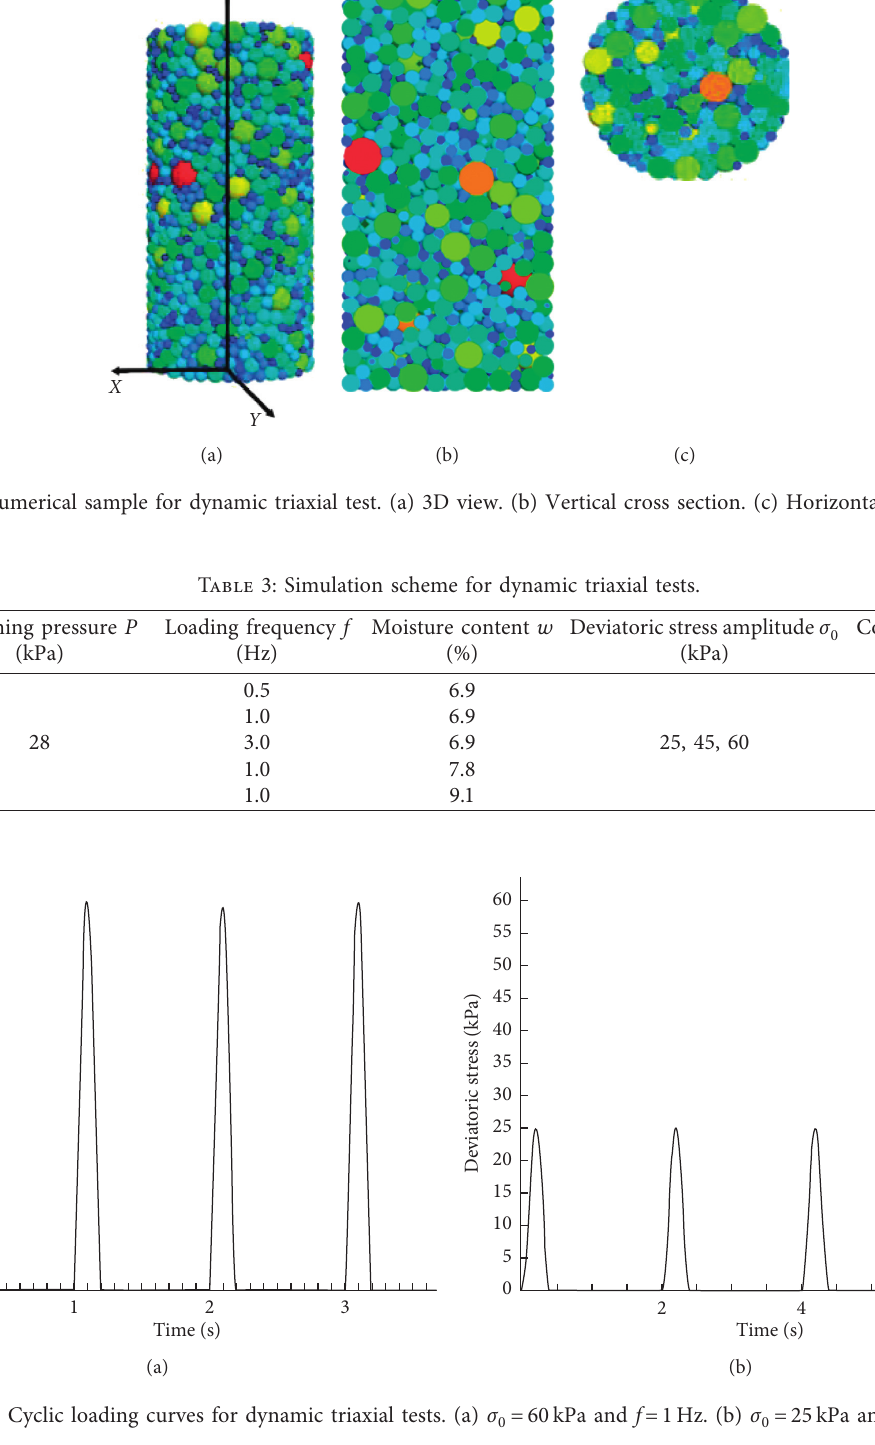
� 60kPa and f � 1 Hz. (b) σ 0